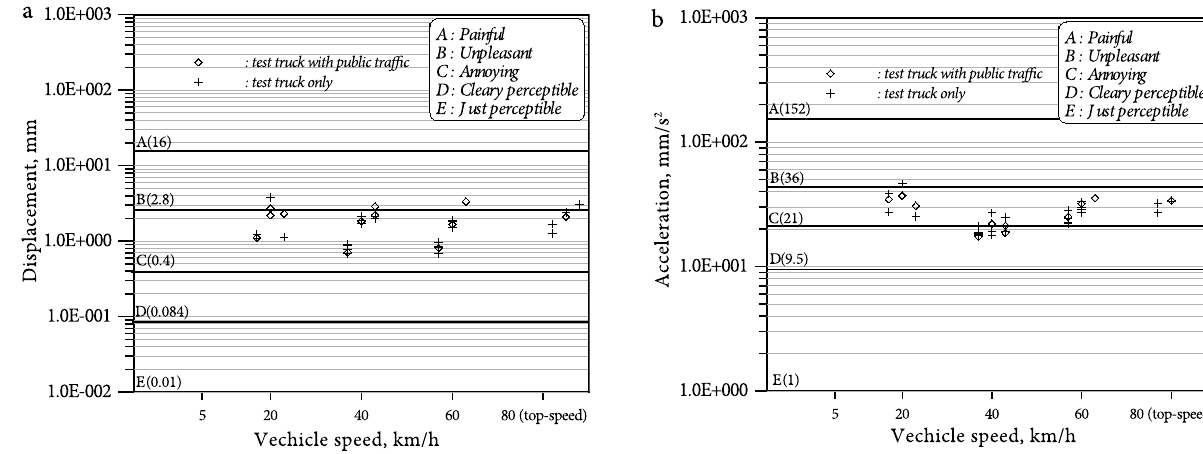
Fig. 8. Max amplitude from dynamic loading test (in-case): a – displacement; b – acceleration